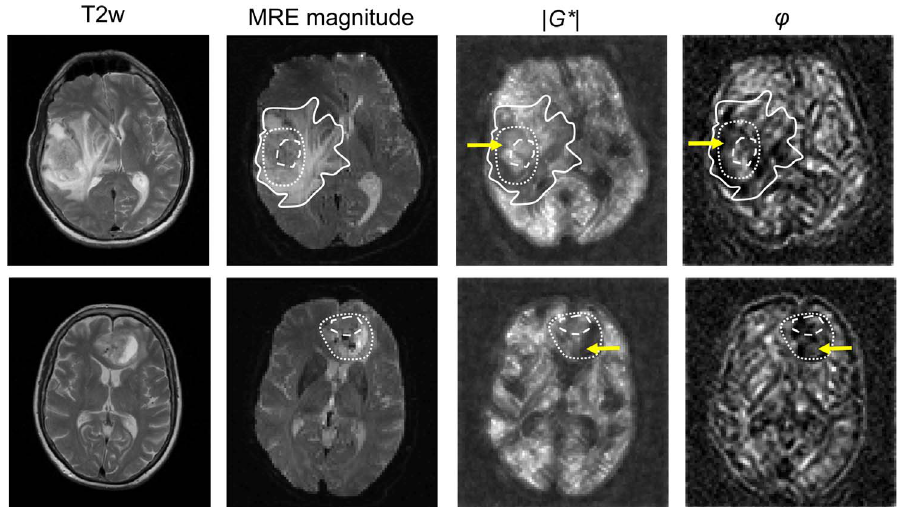
Figure 2. Anatomical T2-weighted images (T2w), MRE magnitude images, and 3DMMRE parameter maps ( |G*| and Q ) of 2 GB patients (upper row: patient # 15, bottom row: patient # 14, corresponding to the tables). The selected regions of tumor (dotted lines) and edema (solid line in # 15) were used for the parameter evaluation as given in Table 2. The region of HAM is indicated by the dashed line. The yellow arrows indicate compartments of soft tissue properties (low |G*| ) but different dissipative behavior ( Q ) in both tumors. |G*| was scaled from 0 to 3 kPa, Q was scaled from 0 to 2.5 rad.